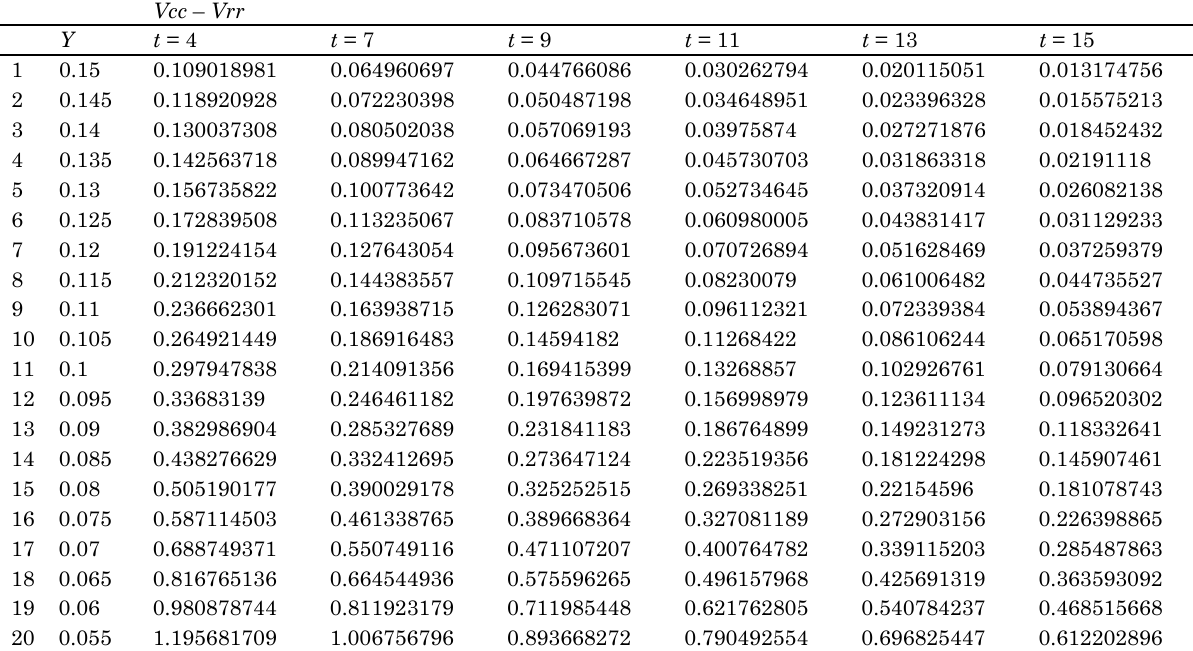
table 9. comparison between DD model in recovery recession phase and cyclical capitalization for different temporal lengths of the market